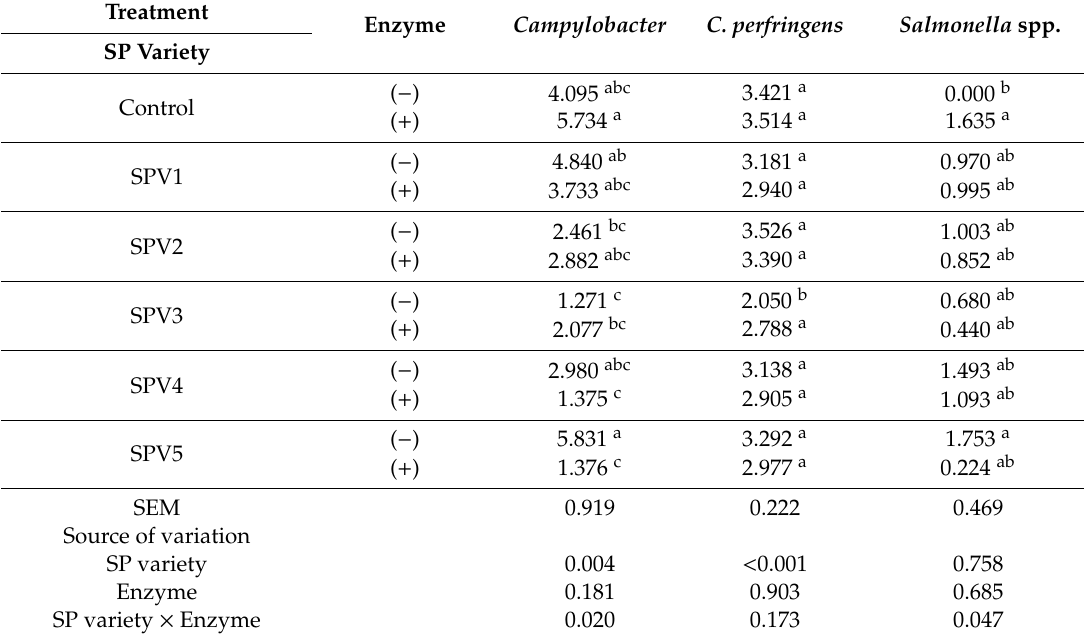
Table 5. Log CFU (g / mL) of cecal content of chickens fed di ff erent sweetpotato